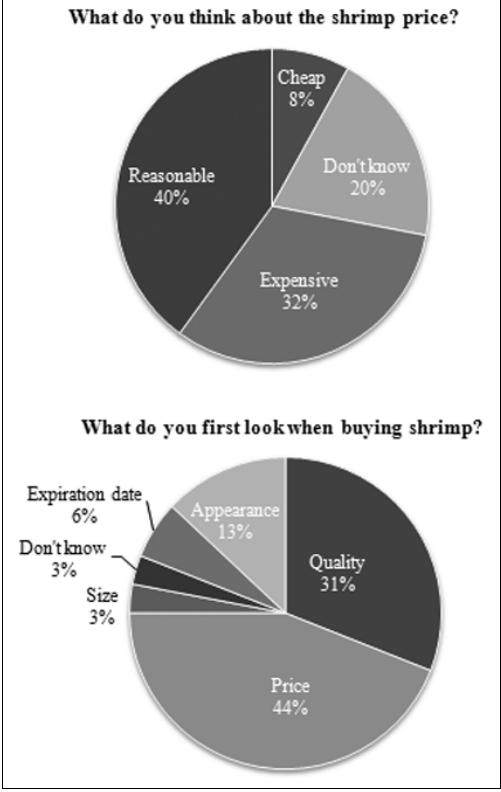
Fig. 3 – Questions destined for final